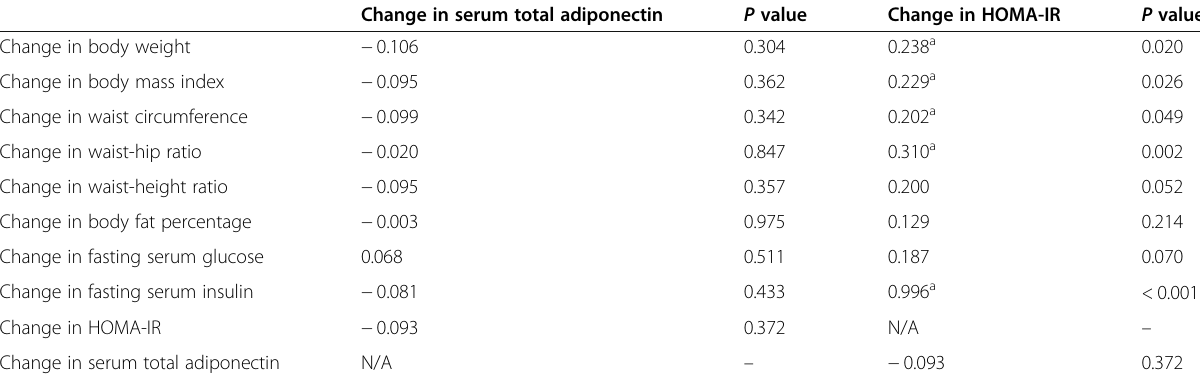
Table 5 Correlations of anthropometric and laboratory characteristics with change (after-before) in serum total adiponectin and HOMA-IR ( n = 95) Change in serum total adiponectin P value Change in HOMA-IR P value Change in body weight − 0.106